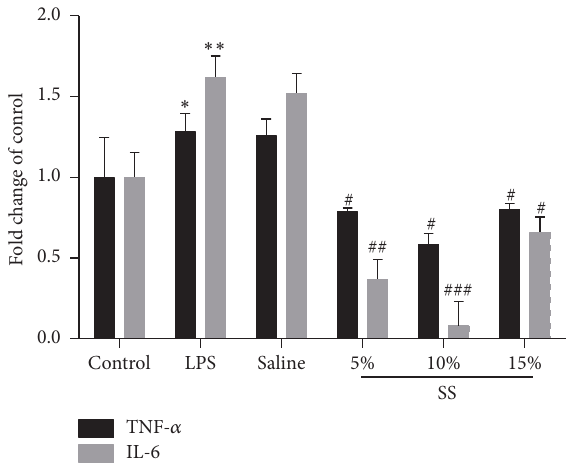
Figure 3: SNN-containing serum inhibits inflammation in LPS stressed Kupffer cells. LPS stressed Kupffer cells were treated with different concentrations of SNN-containing serum (5%, 10%, and 15%) or vehicle; TNF- 𝛼 and IL-6 mRNA expression were detected. Experiments were repeated three times for each group, ∗ 𝑃 < 0.05 and ∗∗ 𝑃 < 0.01 versus control; # 𝑃 < 0.05 , ## 𝑃 < 0.01 , and ### 𝑃 < 0.001 versus LPS stressed cells. SS: SNN-containing serum. Origin from GraphPad Prism 5.01, and data is linked.